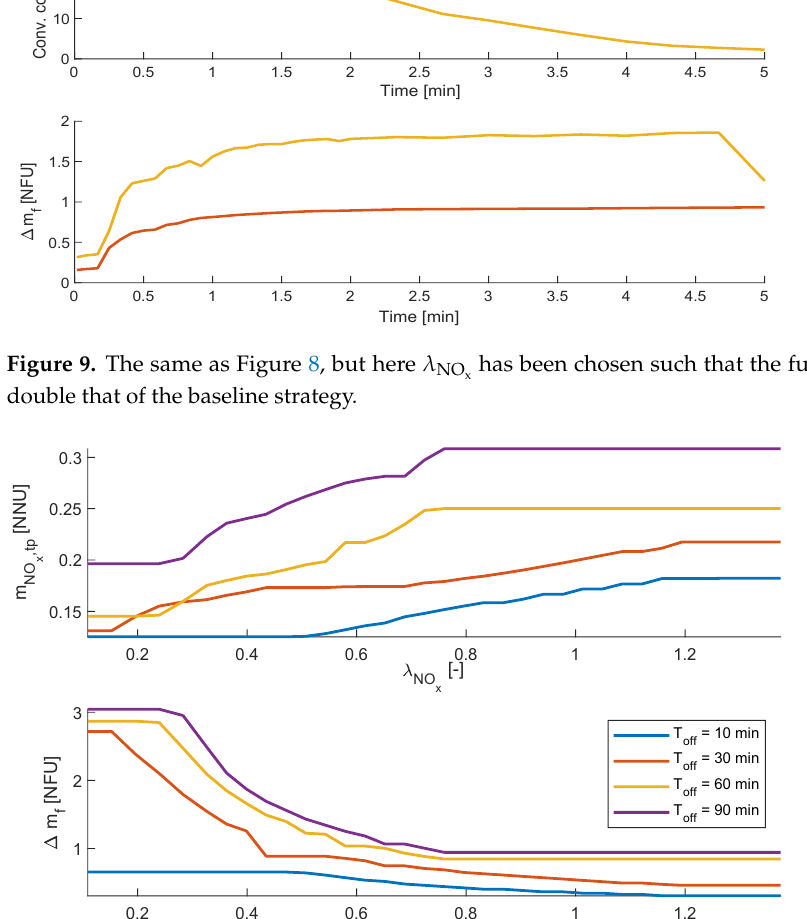
and engine-off times x . For large λ NO , the lines x x , the x